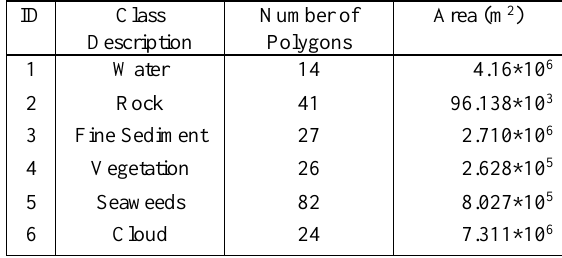
Table 2 . Polygons created for supervised classification